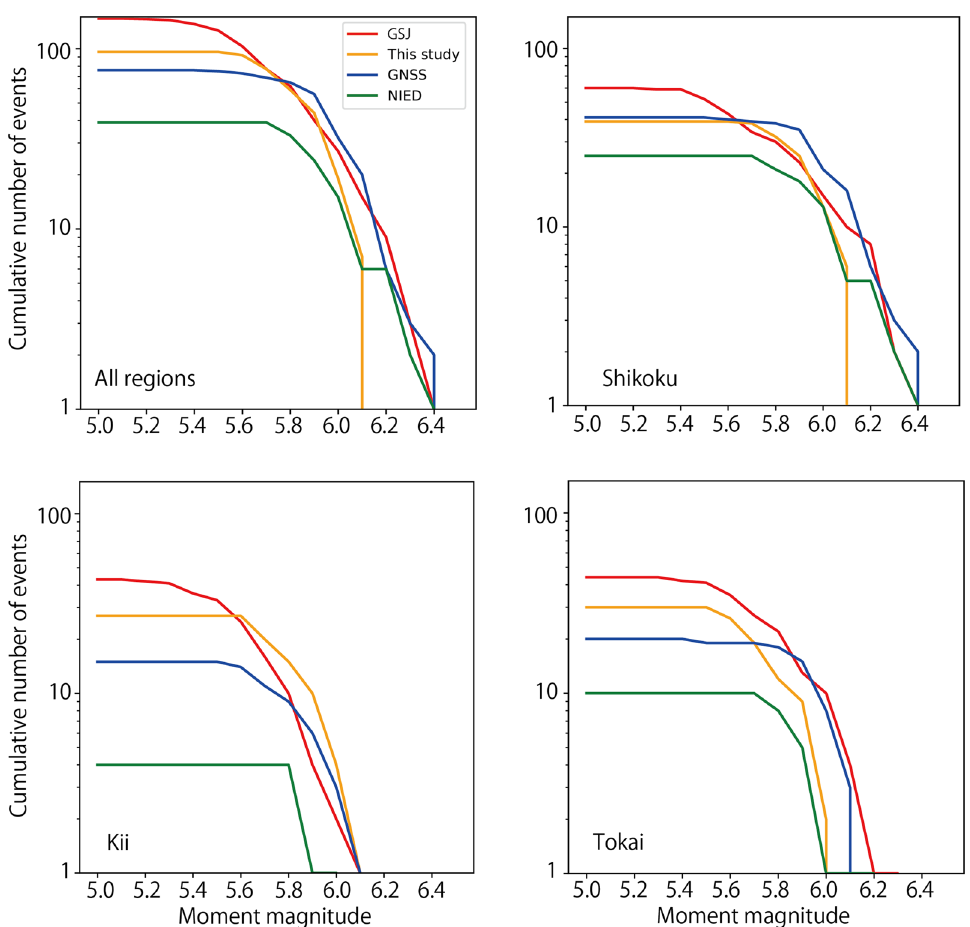
Fig. 9 Cumulative number of events against moment magnitude. Red, green, blue, and orange curves represent the catalogs of the GSJ, NIED, GNSS, and this study,